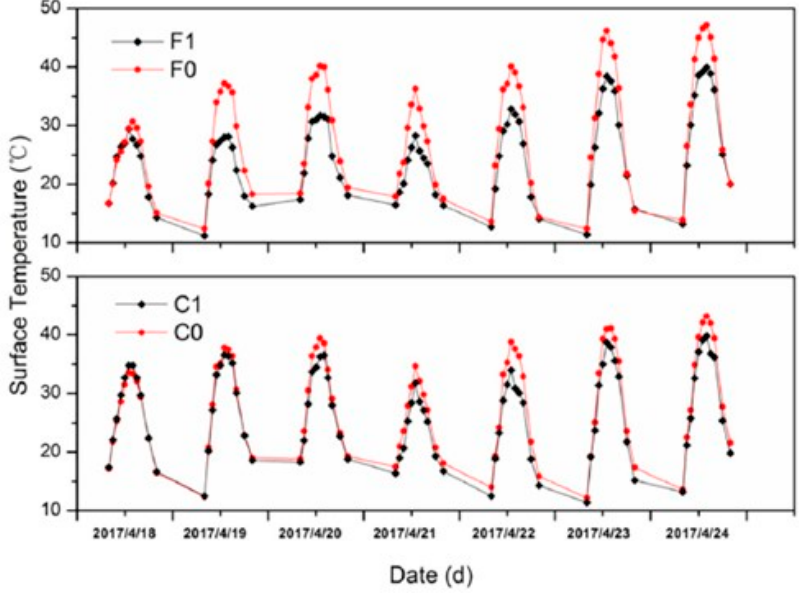
Figure 15. Surface temperature variations of figuline (F1) and conventional concrete pavements (C1)